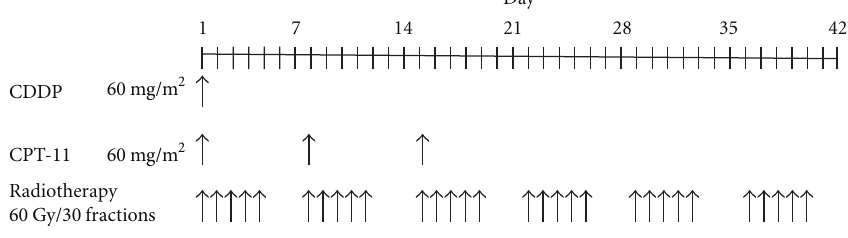
Figure 1: Regimen of irinotecan plus cisplatin in chemoradiotherapy.